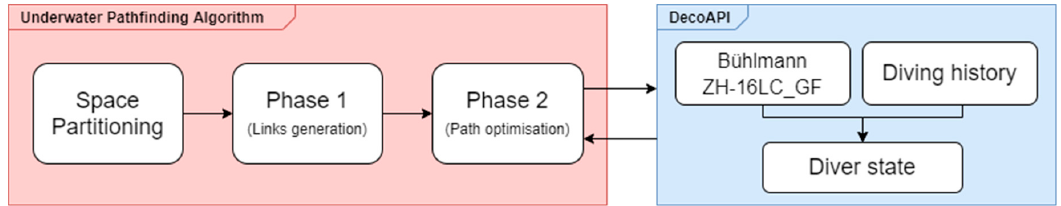
Figure 1. The stages of the pathfinding algorithm and communication with DecoAPI.